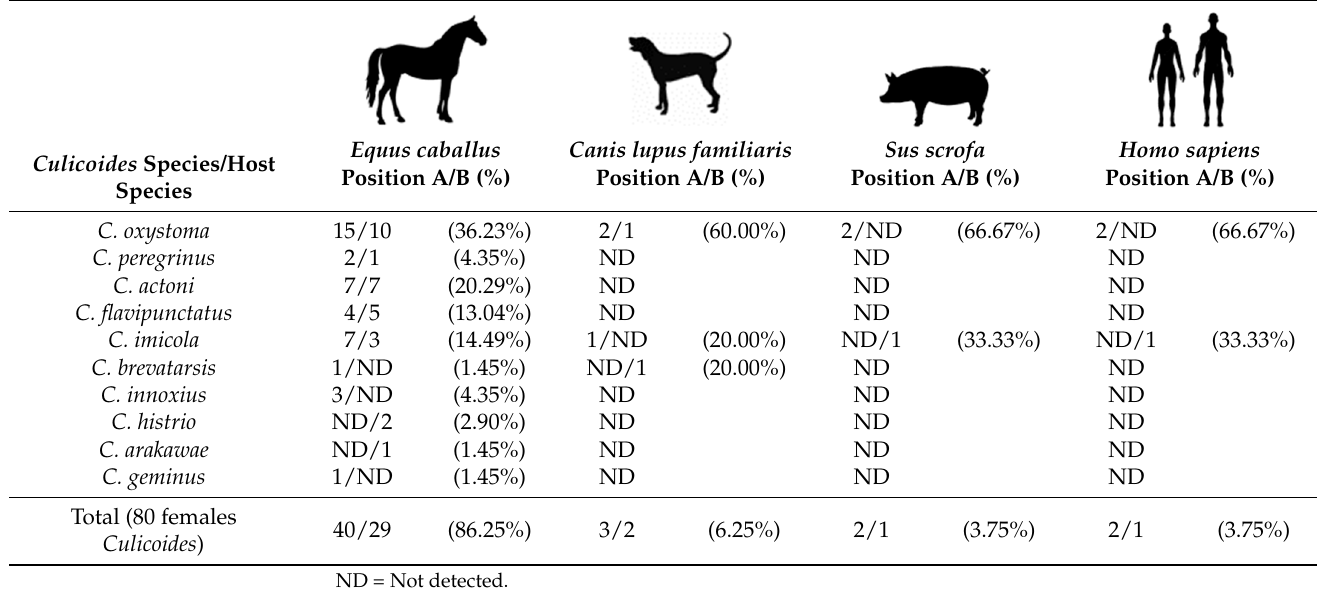
Table 3. Host preference blood meal of female Culicoides collected from AHS-positive horse farms in Hua Hin district, Prachuab Khiri Khan, Thailand, using PNOC gene.